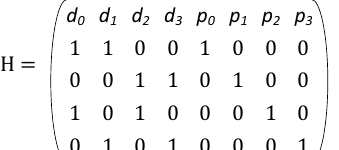
Figure 4. Parity check matrix of a (8, 4) orthogonal Latin square code.